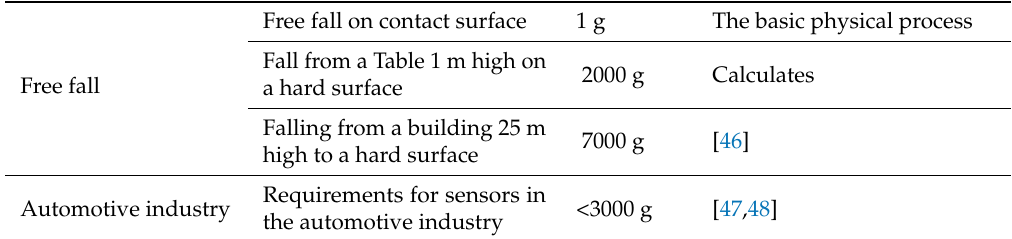
Table 4. Shock amplitudes for general applications.